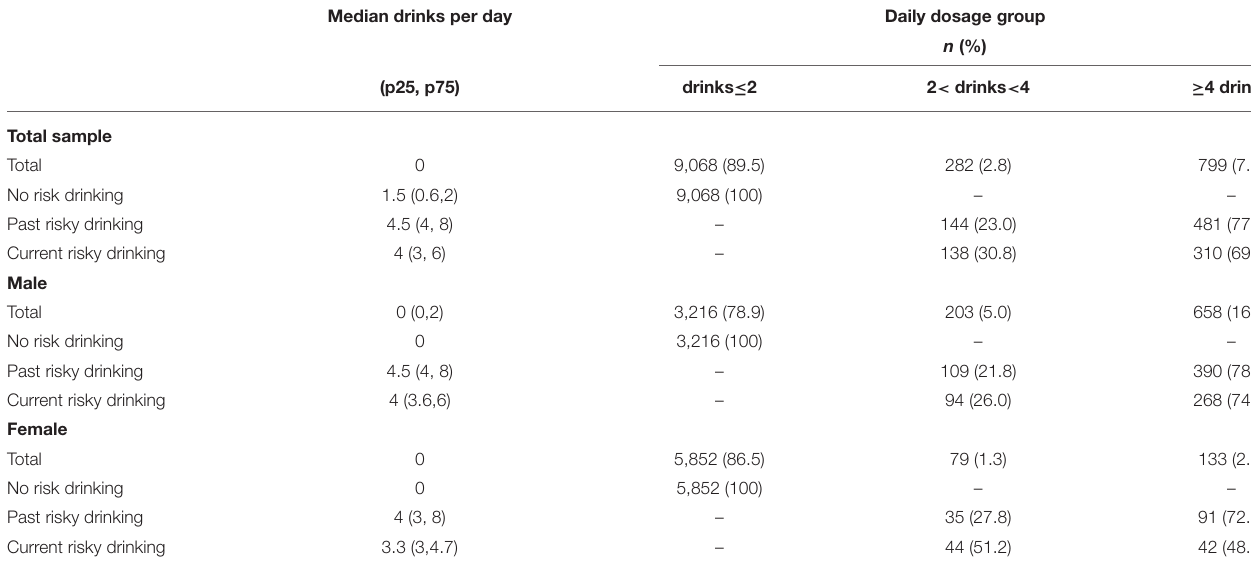
TABLE 2 | Daily dosage of alcohol drinking stratified by risky drinking group and